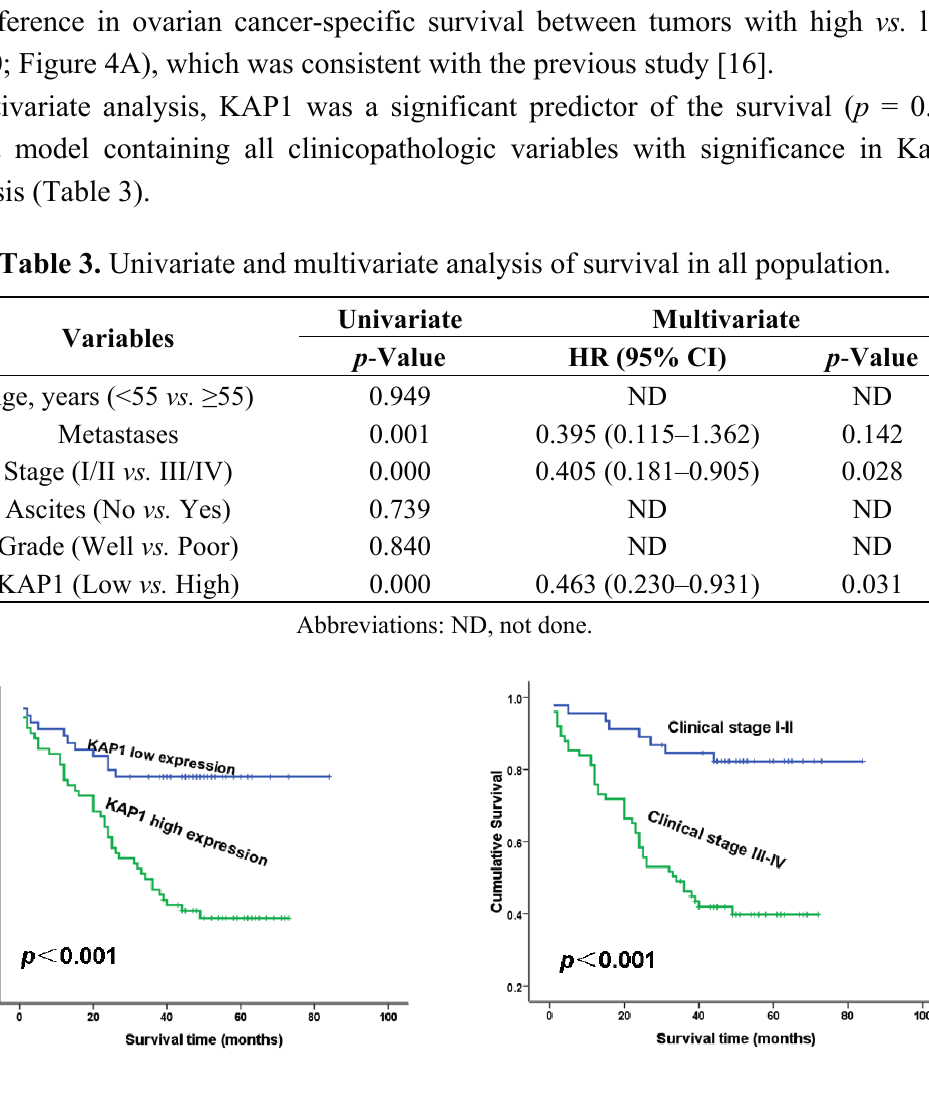
Figure 4. The prognostic effects of KAP1 expression levels in ovarian cancer patients. ( A ) Patients with high KAP 1 expression showed significantly shorter overall survival than those with low KAP 1 expression ( p < 0.001) and ( B ) Patients with stage I–II